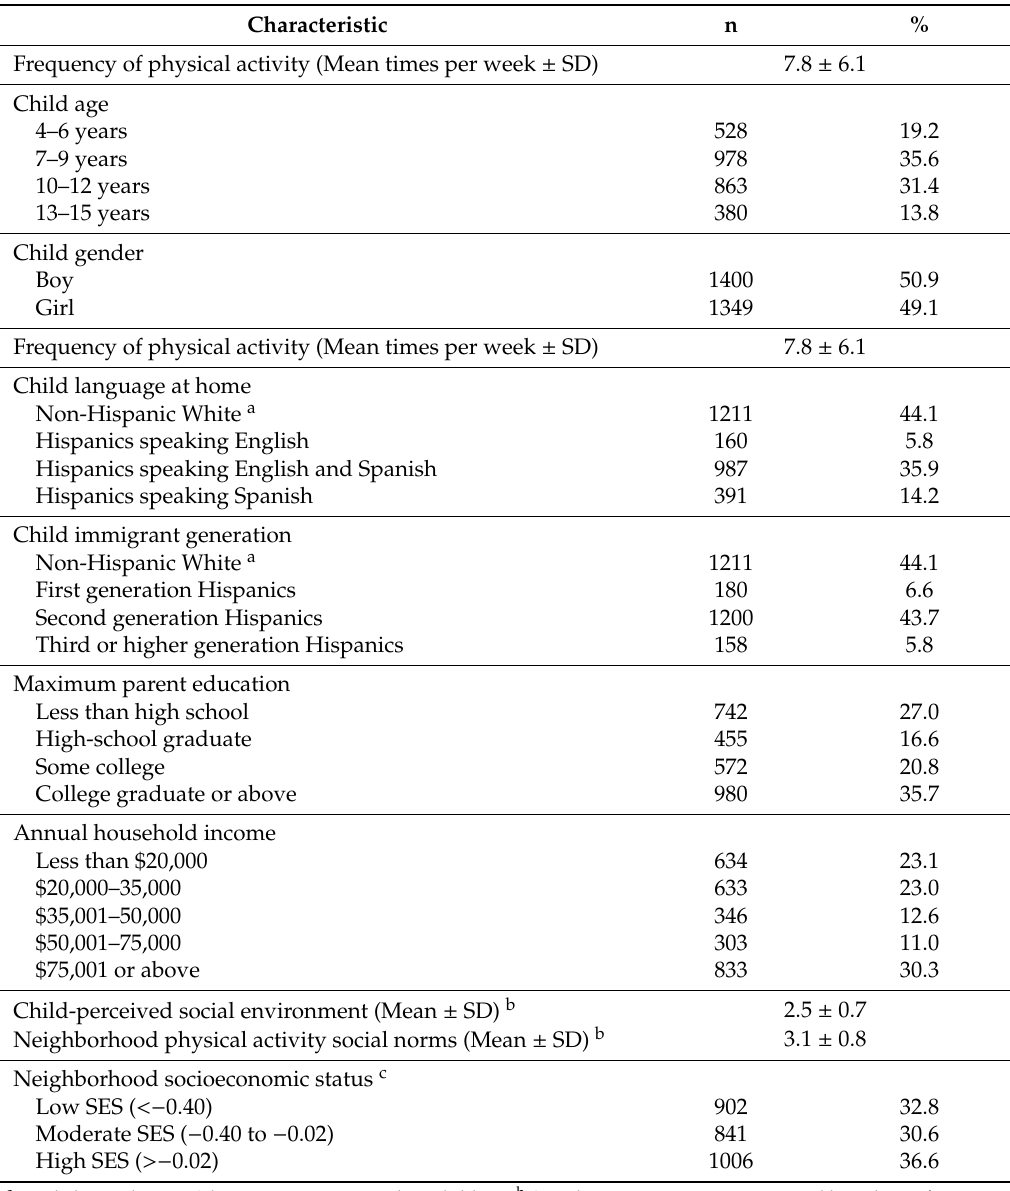
Table 1. Sample characteristics, n =